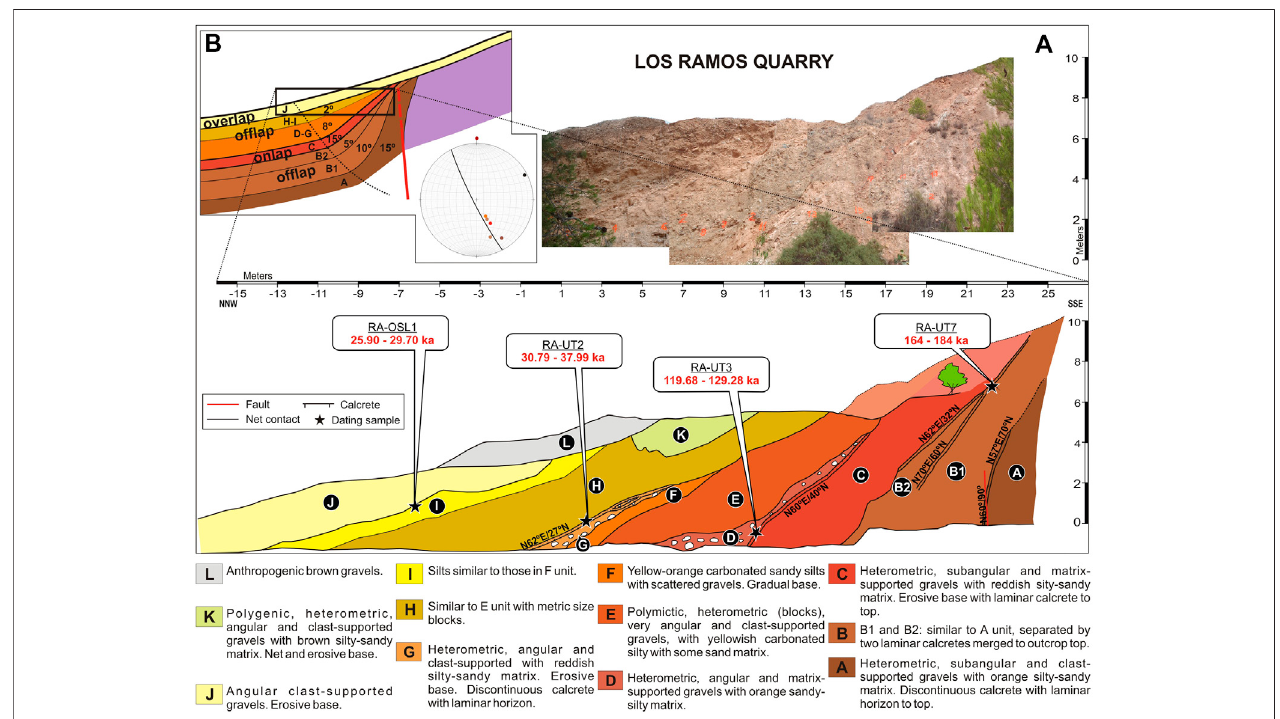
FIGURE 3 | (A) Photographs and log of the Los Ramos quarry outcrop. (B) Scheme of the progressive discordance, identifying depositional phases and rotation anglesofthe limb ofthe propagation fold. Stereographic projection with the polesof thestrati fi cation (stratigraphicmarkers colours on fi gure A) and therotational axis of the layer (or the plane containing the poles of the strati fi